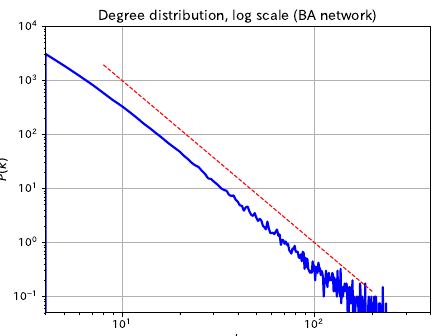
Figure 3. Degree distribution of the BA network in log scale; N = 10,000, (cid:104) k (cid:105) = 8. The average over 40 samples. The function k − 3 is plotted by a red dotted curve for convenience.